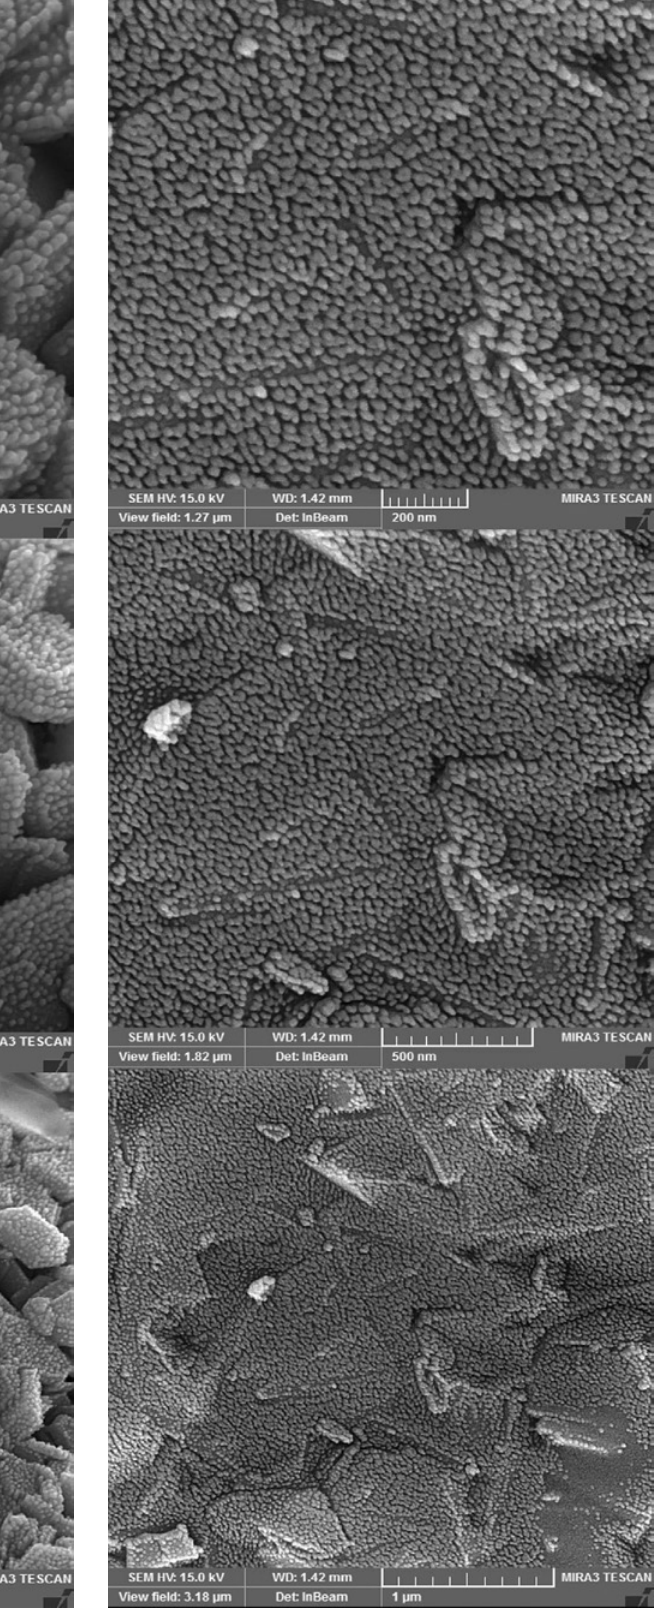
Figure 5: SEM images at 850 ° C obtained by citric acid. Figure 6: SEM images of SrFe prepared with citric acid-EG at 850 °